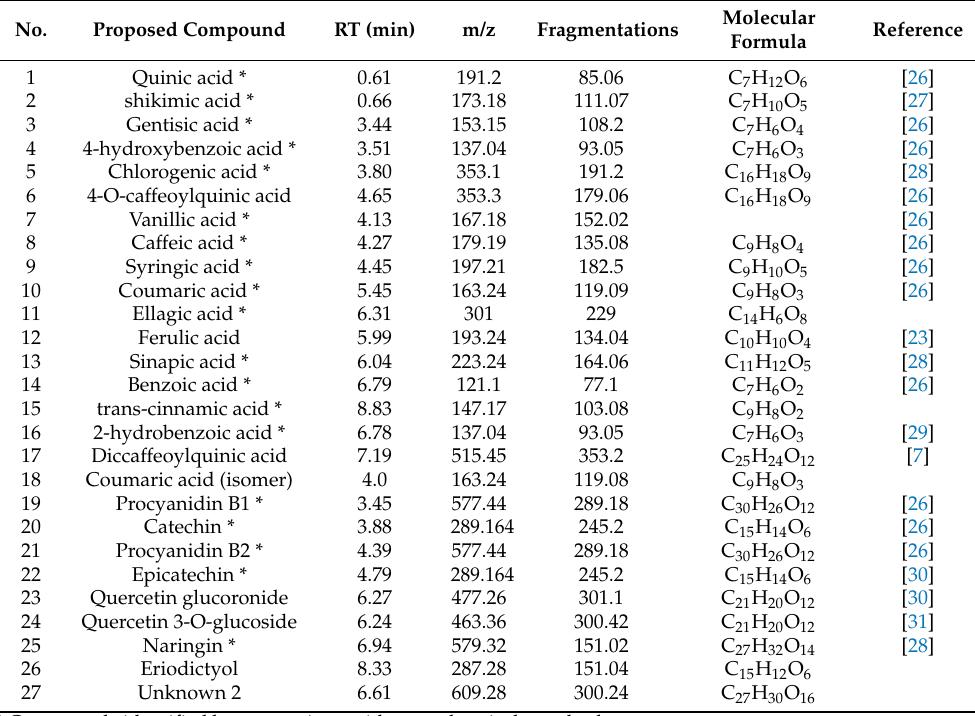
Table 3. Identification of phenolic compounds present in the avocado peel